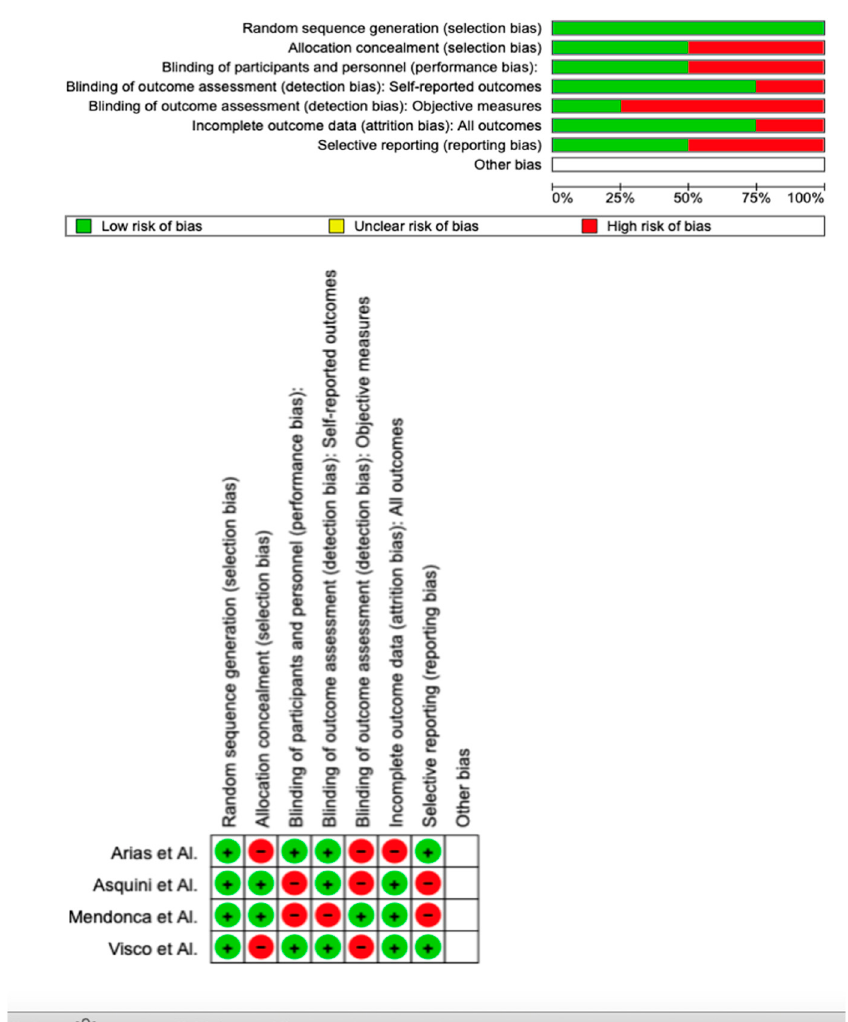
Figure 2. Risk of bias [51–54]. Green are low risk of bias; red are high risk of